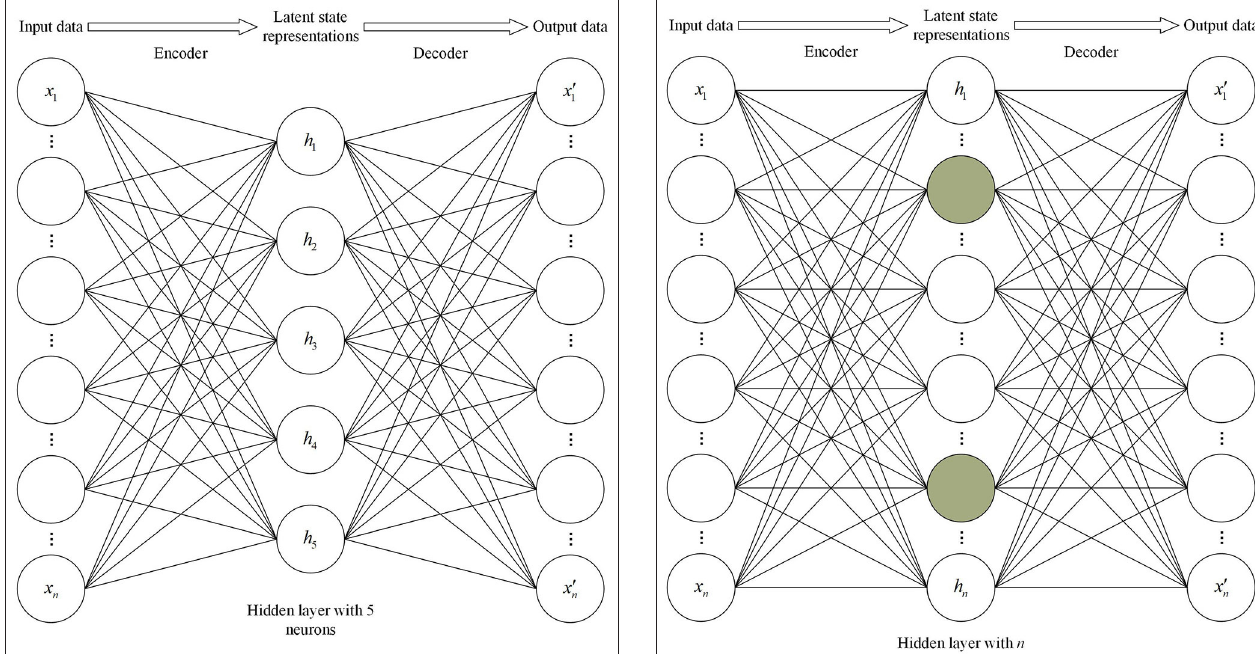
FIGURE 2 | Architecture of the single-hidden-layer undercomplete auto-encoder.